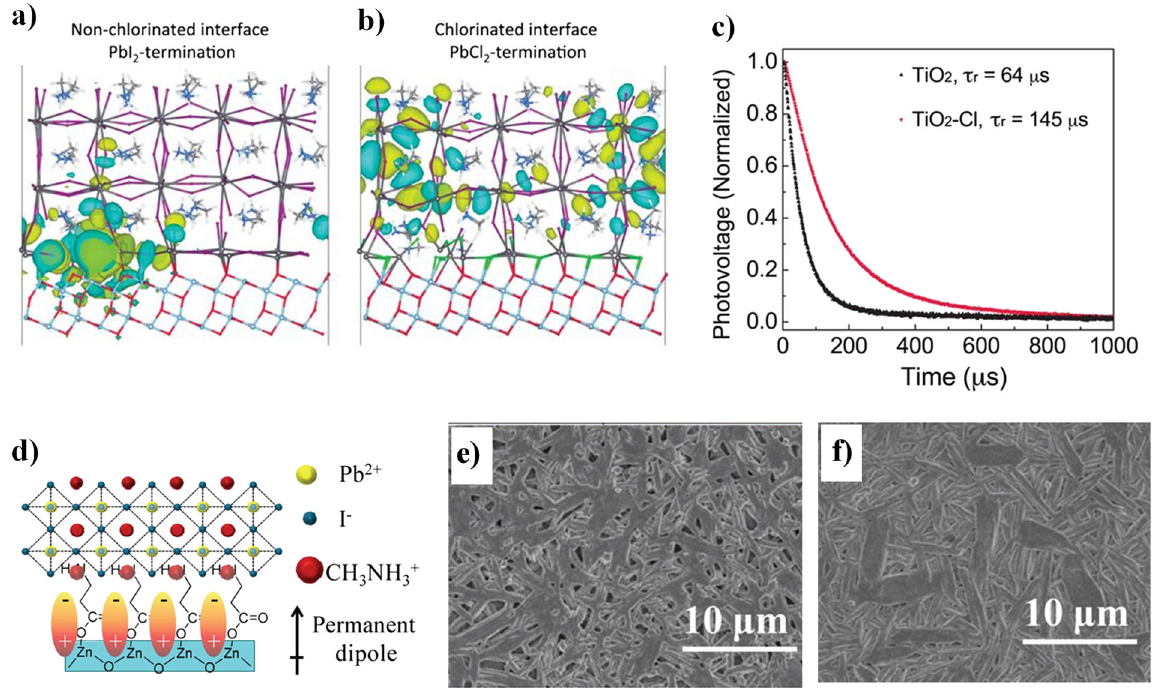
Fig. 5 Substrate modi fi cation for high-quality perovskite fi lms. a Trap-like localized antisite defects form states near the valence band edge for the PbI 2 -terminated TiO 2 /perovskite interface. b Shallow and delocalized Pb-Cl antisite defects are seen for the PbCl 2 -terminated interface. c Normalized transient photovoltage decay of solar cells with TiO 2 and TiO 2 -Cl as electron transport layers. 128 d Schematic diagram of SAM induced permanent dipole formation and involvement of the SAM in the crystalline structure of perovskite crystals. SEM images of CH 3 NH 3 PbI 3 perovskites on e bare ZnO and f ZnO/C3-SAM.